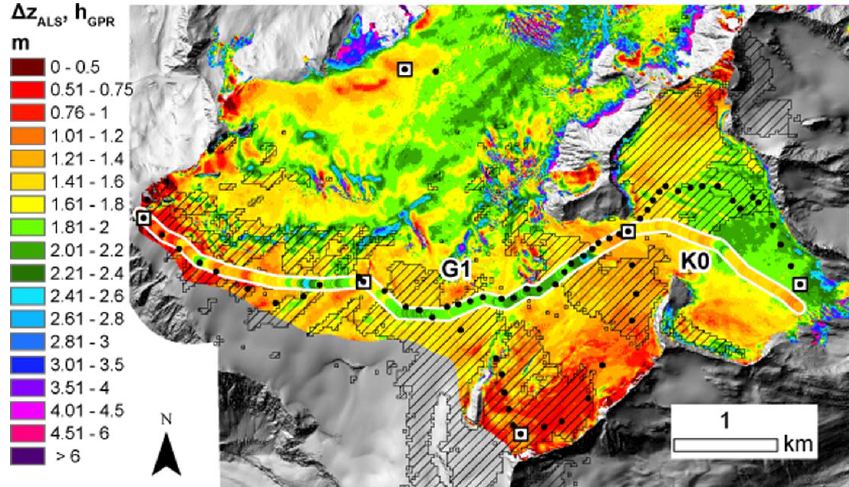
Fig. 7. Spatial distribution of ALS-derived surface elevation changes for 10 October 2010 to 23 April 2011. Snow depths calculated from GPR measurements along the profiles at Gepatschferner and Kesselwandferner shown in the same colour-scale. Black dots indicate locations of snow depth probing. Locations of snow pits are shown as white squares. Snow covered areas derived from Landsat image of 31 August 2009 (LSC) are